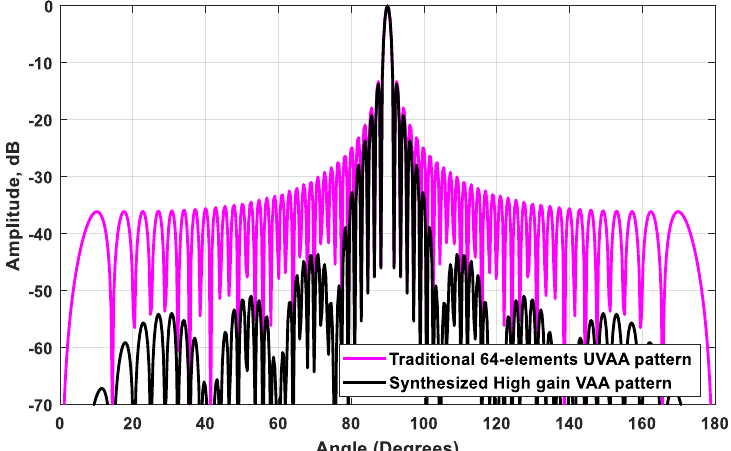
Figure 6. The synthesized high-gain VAA pattern for M = 8, Q = 2, L = 8, and d s = d = λ /2, compared to the traditional 64-element UVAA pattern.